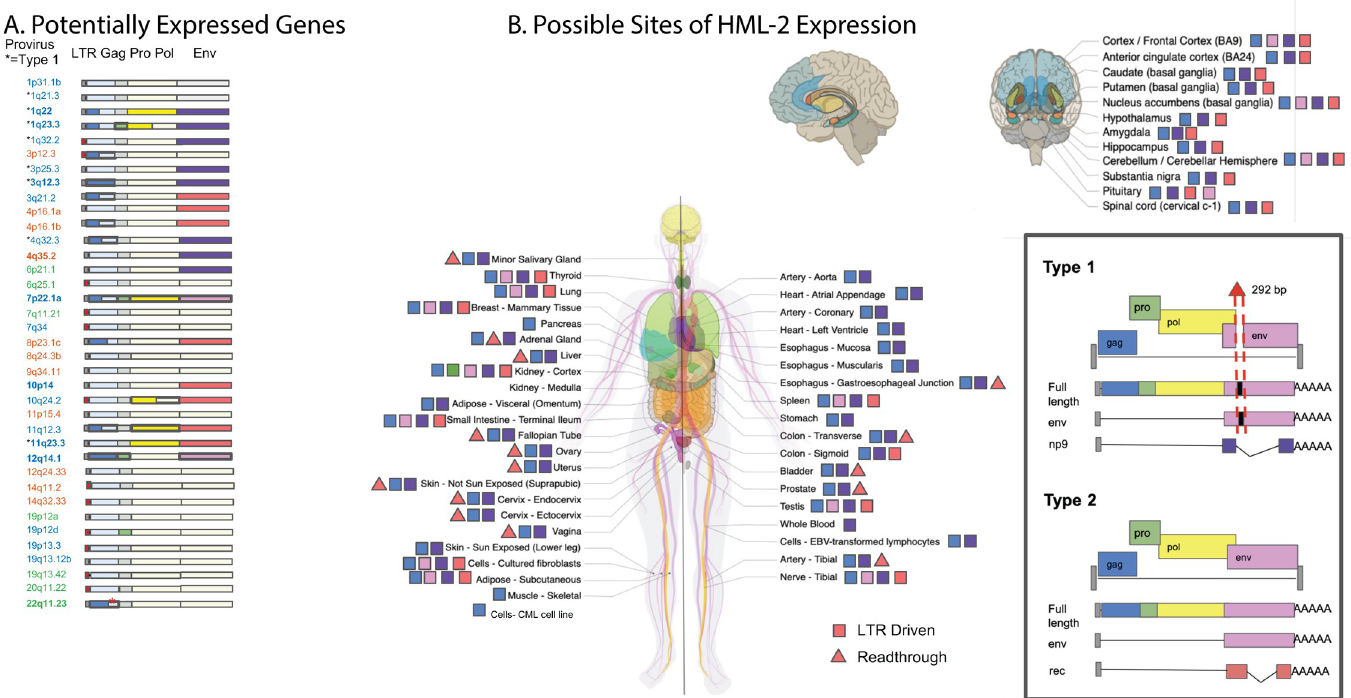
Fig 8. Potential consequences of HML-2 expression in the GTEx dataset. ( A ) Schematic of each provirus expressed at TPM > 1 in the GTEx dataset. Each ORF and LTR is designated with a colored box; a filled box represents an intact ORF. A partial LTR is represented by a red box. Colors are explained in the legend. Asterisks next to the provirus locations indicate type 1 proviruses, which are incapable of expressing env or rec , but rather express np9 . Bold text represents an LTR-driven provirus. ( B ) Each body site included in the GTEx dataset is represented in this diagram, copied from the GTEx portal, with permission. All nonbrain tissues are labeled on the body; a zoom out of the brain labels each of its tissues individually. A colored symbol next to each body site denotes which intact ORFs could be expressed in that body site based on provirus sequence and transcriptome analysis. A square indicates LTR-expressed genes; a triangle indicates other potentially expressed genes. The box in the lower right displays the colors of each ORF and shows the differences between type 1 and type 2 proviruses. The � marks a polymorphic insertion in the provirus at 22q11.23 that breaks the Gag ORF in 43% of the population and is found in the hg38 reference genome. This figure used expression data from S1 Data along with ORF data from S1 Table and sequence alignments using the coordinates from S1 Table. GTEx, Genotype Tissue and Expression; HML, human mouse mammary tumor virus-like; LTR, long terminal repeat; ORF, open reading frame; TPM, transcripts per